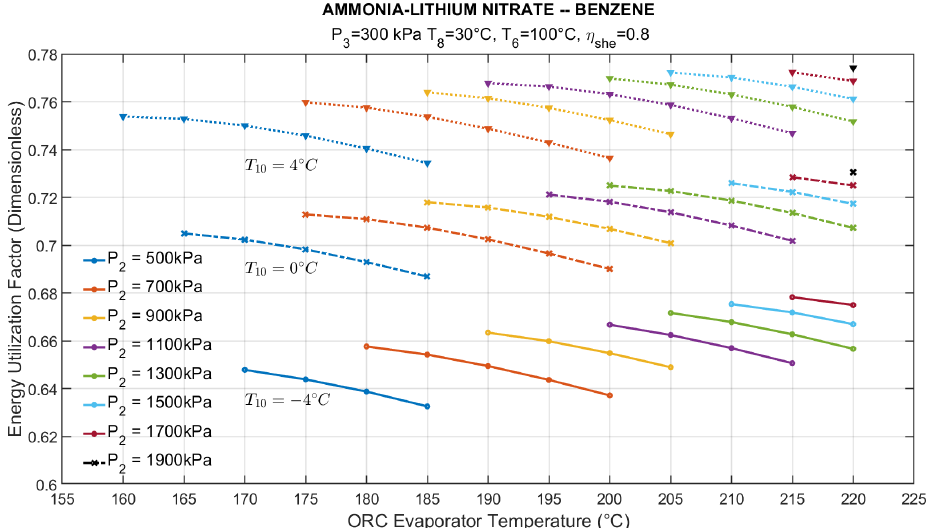
Figure 5. NH 3 -LiNO 3 –C 6 H 6 effect of heat source and cooling temperatures on EUF.